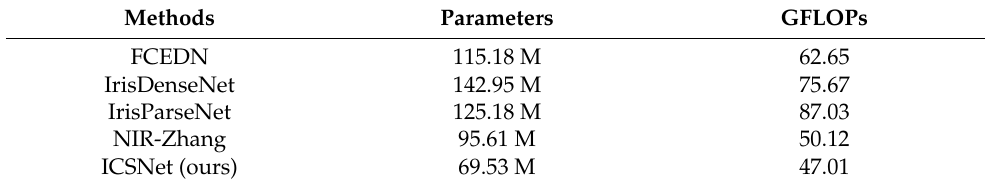
Table 4. Comparison of parameters and GFLOPs.